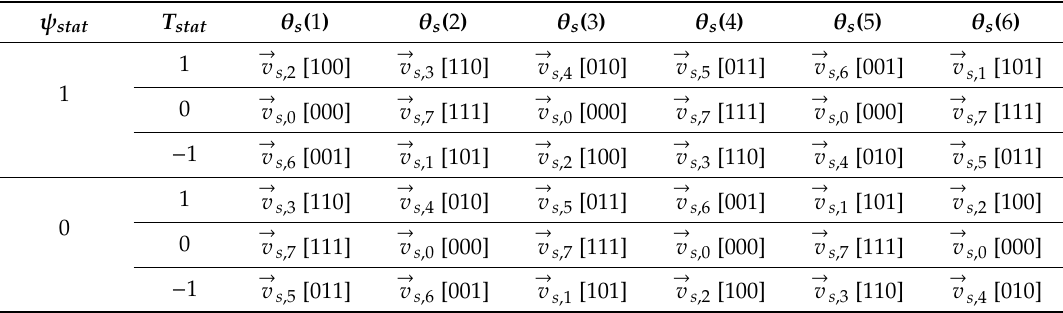
Table 1. Selection of voltage